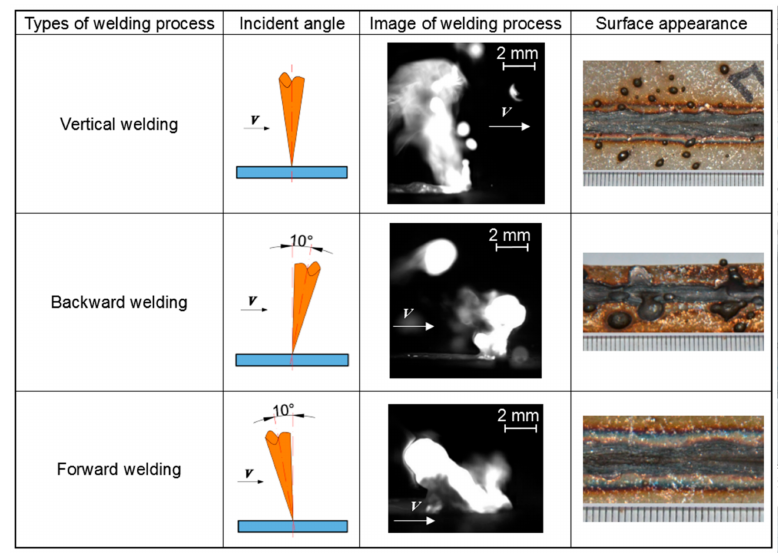
Figure 7. Effect of the incident angle on the weld pool and surface appearance (p = 10 kW, v = 1.8 m/min, ∆ = +10 mm, q = 30 L/min).